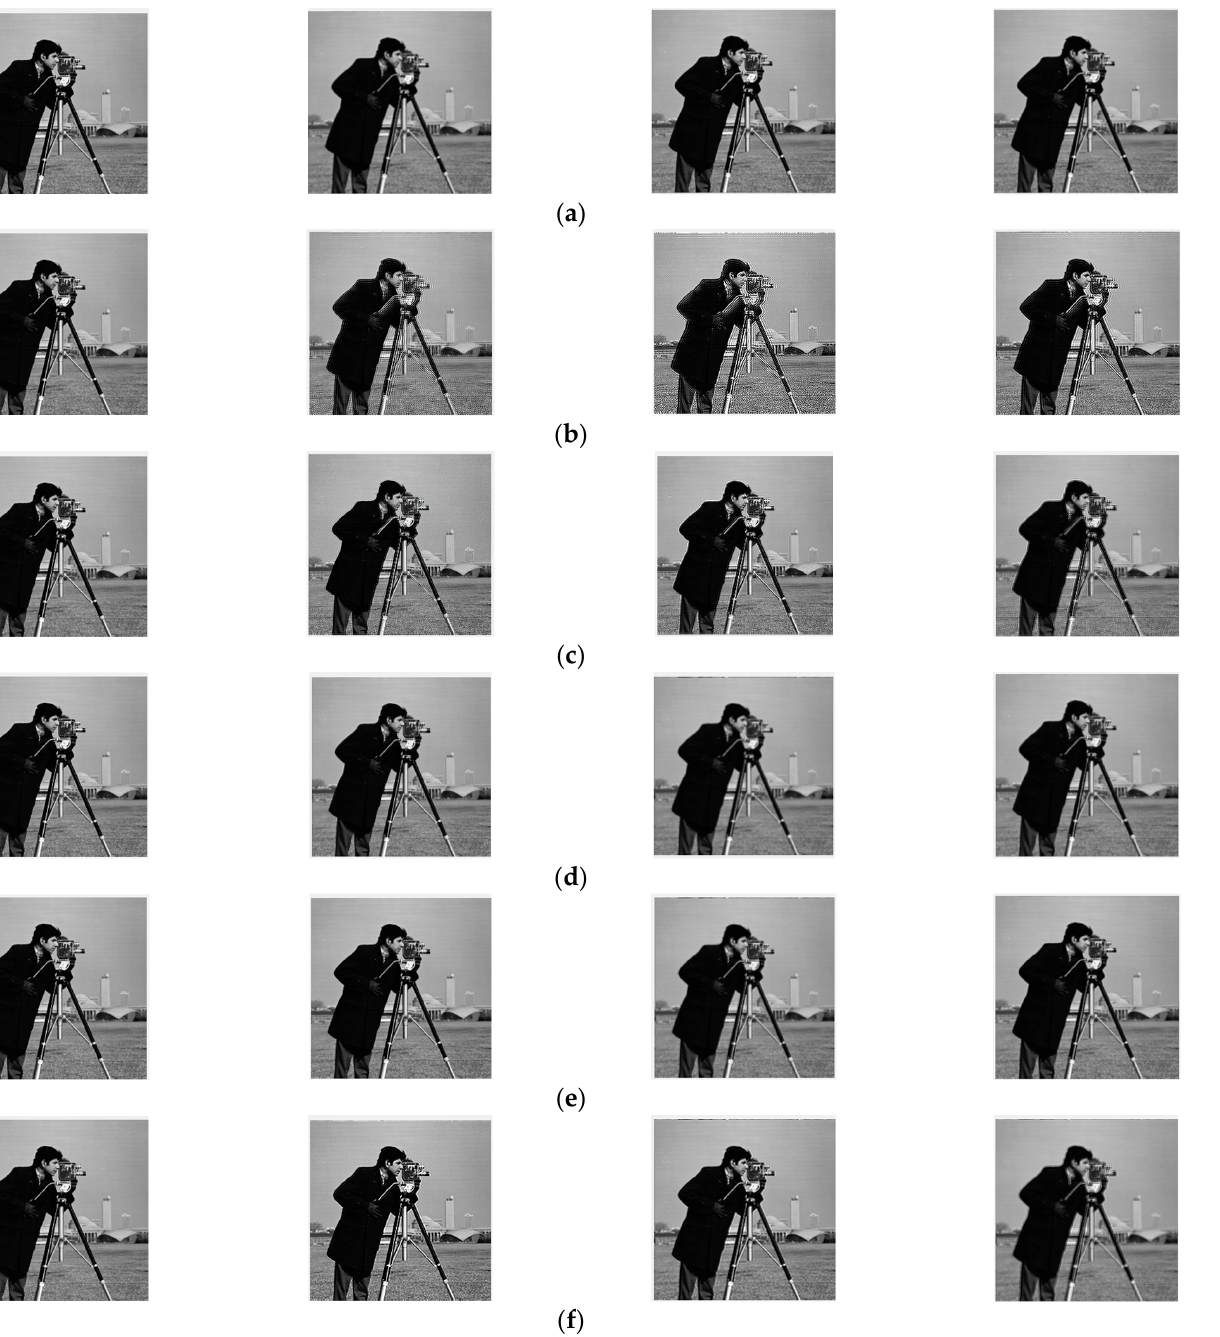
Figure 10. Simulation results of six different phase masks at defocus value of 0, 20, 40 and 60. ( a ) Improved exponential phase mask. ( b ) Exponential phase mask. ( c ) Cubic phase mask. ( d ) Sinusoidal phase mask. ( e ) Improved logarithmic phase mask. ( f ) Tangent phase mask.